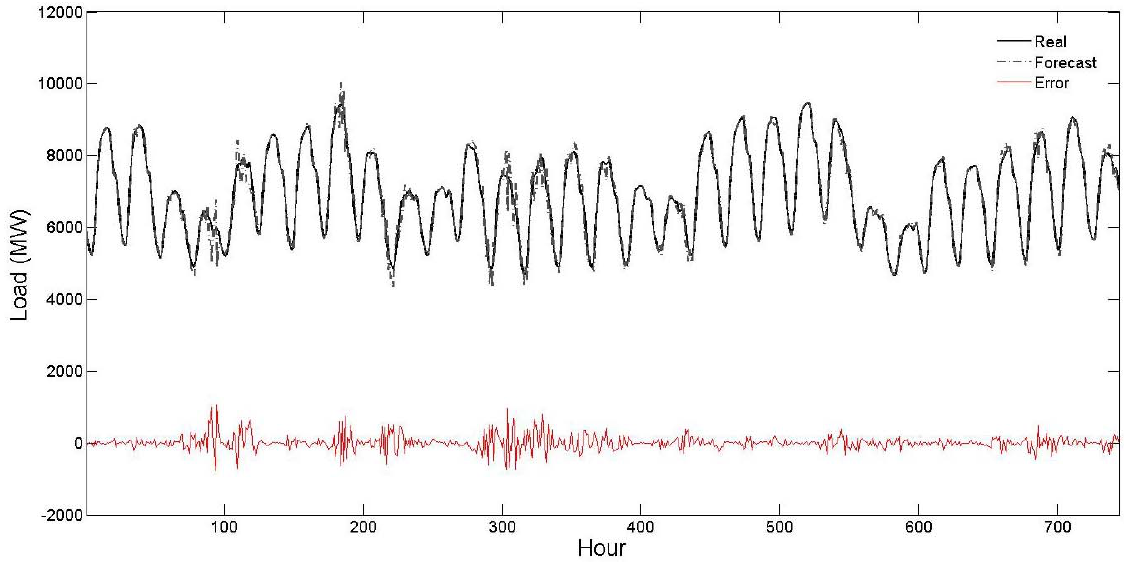
Figure 7. Curves of real values, forecast values and forecast errors for the test month of July 2004 of Table 5 (the forecast results are related to the proposed